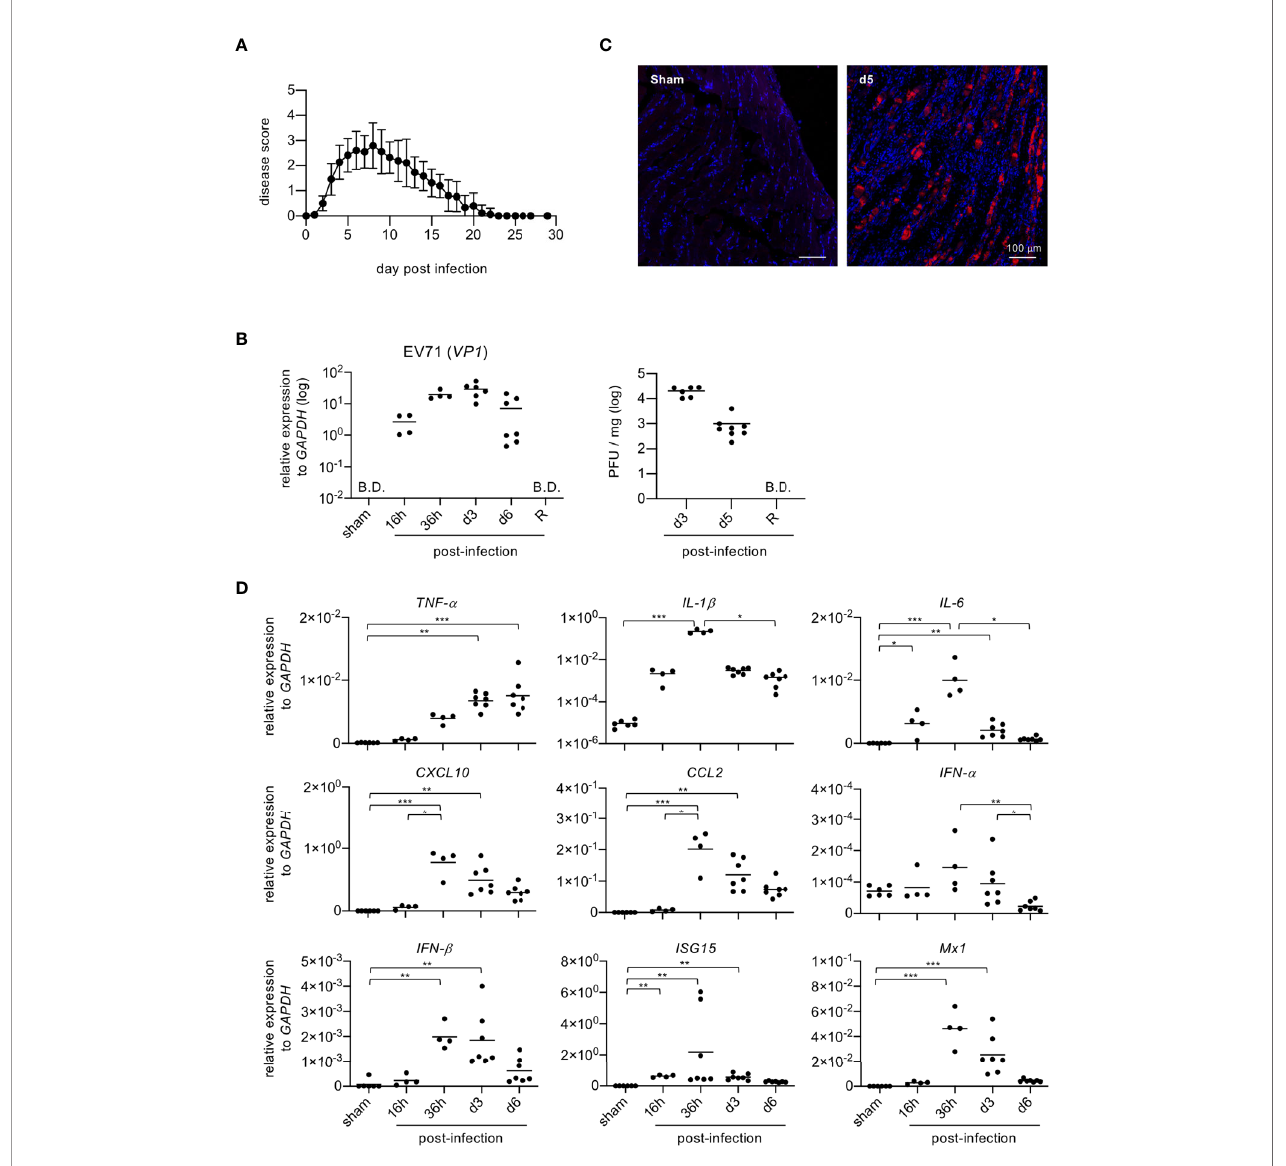
FIGURE 1 | Mouse pups infected with EV71 show rapid induction of in fl ammatory cytokines and anti-viral molecules in skeletal muscle. (A) Mouse pups (P11-P12, n = 23) were injected i.p. with EV71 virus (8 × 10 5 PFU) at day 0 and monitored daily for limb paralysis. Clinical scores: 0, no sign of disease; 1, weakness in one or two hindlimbs (wobbling); 2, paralysis in one hindlimb; 3, paralysis in both hindlimbs; 4, paralysis in both forelimbs plus both hindlimbs; 5, death. (B) Gastrocnemius and soleus muscles were collected from sham-infected or EV71-infected mice at indicated times, and real-time quantitative PCR was performed to determine gene expression levels of EV71 viral gene vp1 (left panel). Lysates from gastrocnemius and soleus muscles of EV71-infected mice at day 3 and day 5 post-infection, and at recovery phase (R) were subjected to plaque assay (right panel). R represents mice that recovered from limb paralysis and wobbly status (score = 1). Each symbol represents one mouse (n = 4-8). B.D. represents below determination. (C) Cryosections of gastrocnemius muscle from sham-infected or EV71-infected mice at day 5 post-infection were subjected to immuno fl uorescence staining with the rabbit antibody to viral protein VP1 and then Cy3-conjugated anti-rabbit IgG (red) followed by DAPI counterstain (blue). (D) Real-time quantitative PCR was used to probe gene expression levels of pro-in fl ammatory cytokines and chemokines ( TNF-a, IL-1 b , IL-6, CXCL10 and CCL2 ) and anti-viral molecules ( IFN- a , IFN- b , ISG15 and Mx1 ) in muscle samples described for [ (B) , left panel]. Gene expression levels were normalized to GAPDH. P values in (B, D) were calculated by Kruskal-Wallis test with Dunn ’ s multiple comparison test. * P < 0.05; ** P < 0.01; *** P < 0.001; **** P <